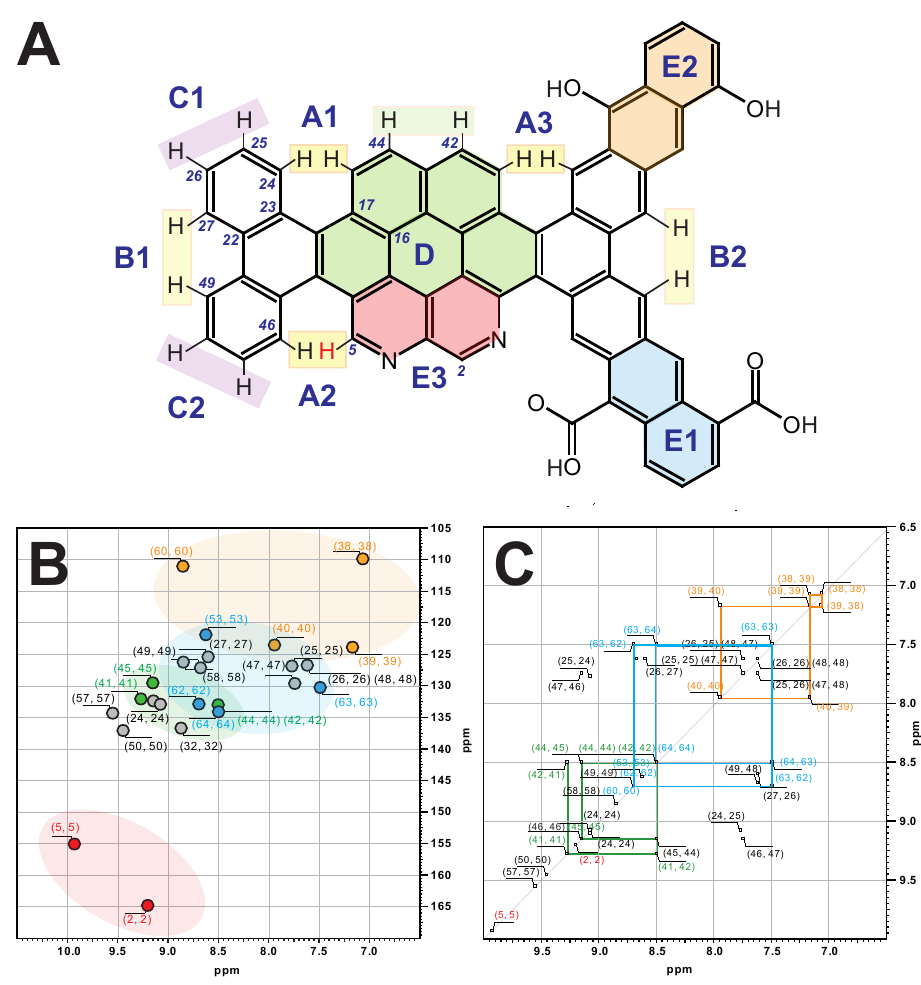
Fig. 11. Conceptual model of polycyclic aromatics to elucidate prospective NMR properties of marine thermogenic carbon (TMOC; cf. text). (A) Molecular formula of PAH model C 65 H 34 N 2 O 6 (IUPAC mass: 938.975Da) with specific chemical environments provided